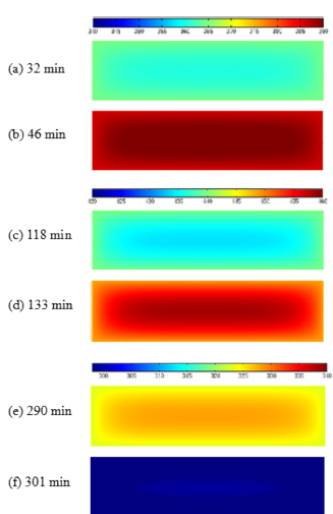
Figure 6. Distribution of temperature on the cross section at x = 5.08 in the course of curing from the viscoelastic model. ( a ) 32 min; ( b ) 46 min; ( c ) 118 min; ( d ) 133 min; ( e ) 290 min; ( f ) 301 min.